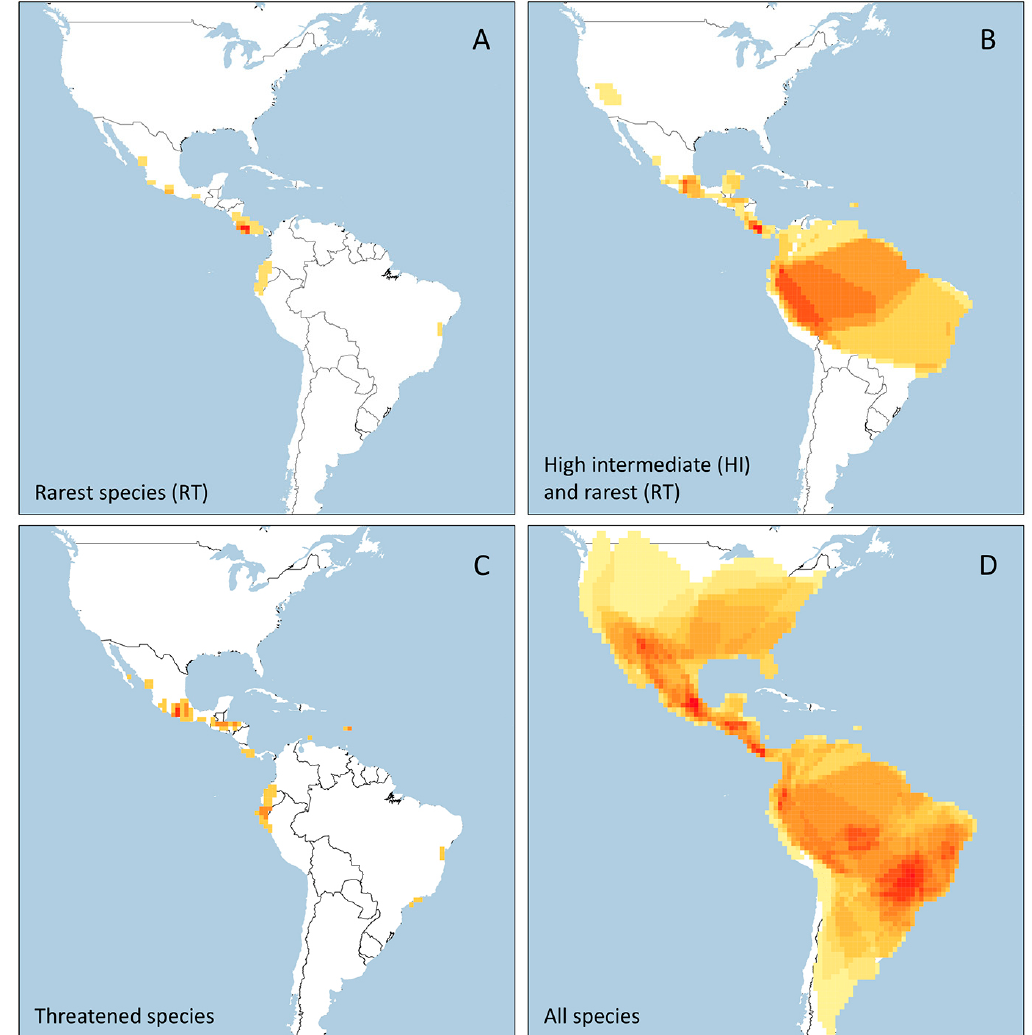
Figure 2. Maps depicting the species richness of New World pitvipers, according to different rarity and threat status categories. ( A ) Distribution of the rarest species (category RT); ( B ) distribution of rare species considering both higher rarity categories (HI and RT); ( C ) distribution of threatened species (IUCN (International Union for Conservation of Nature) categories critically endangered, endangered, and vulnerable); ( D ) species richness of all New World pitvipers.